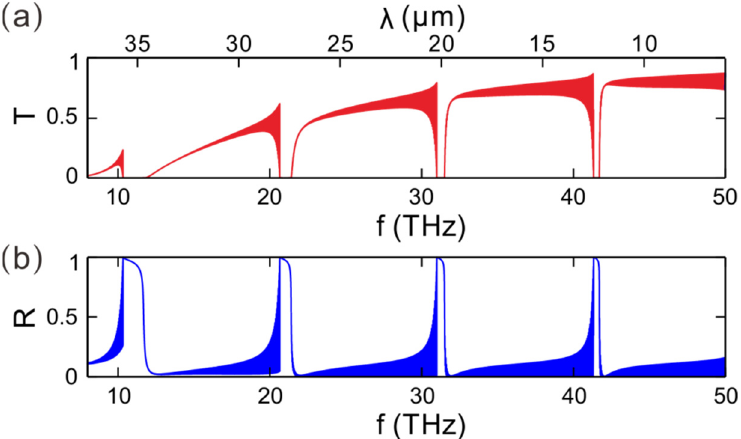
Figure 2. ( a , b ) Transmission and reflection spectra for the normally incident light waves from the left, respectively. The spatial intervals are set as d 1 = 10 nm and d 2 = 10 μ m,